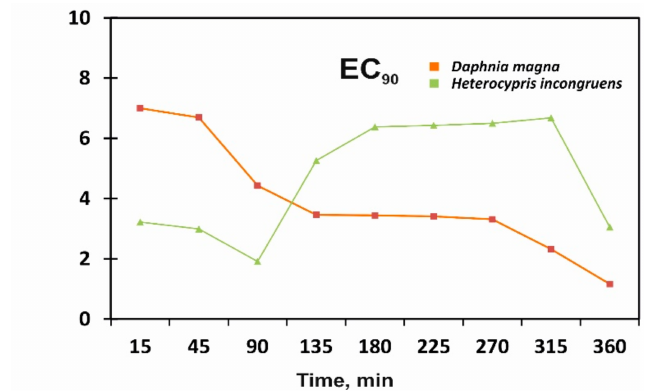
Figure 3. Effective concentration changing through exposure (15–350 min) of daphnia ( Daphnia magna ) and ostracod ( Heterocypris incongruens ) to Decis ® 2.5 EC. The effective concentration responsible for the 20% immobilization of ostracods de- creased from 0.20 × 10 − 3 % (0.05 mg L − 1 of deltamethrin) in 15 min to 0.14 × 10 − 3 % (0.04 mg L − 1 of deltamethrin) of Decis ® 2.5 EC after 90 min of exposure (Table 6). After 135 min of the experiment, ostracods acclimatized to the tested insecticide. The high- est EC 20 = 2.19 × 10 − 3 % (0.55 mg L − 1 of deltamethrin) of Decis ® 2.5 EC was noted after 225 min. A similar tendency of changes was observed in the EC 50 . The EC 50 after 15, 90, and 225 was 1.27 × 10 − 3 %, 0.47 × 10 − 3 %, and 4.65 × 10 − 3 %, respectively (0.32, 0.12, and 1.16 mg L − 1 of deltamethrin, respectively) (Table 6, Figure 3). Table 6. Effect of Decis ® 2.5 EC on immobilization of Heterocypris incongruens. The table contains the mean (m) and 95% confidence intervals ( CIs ) for